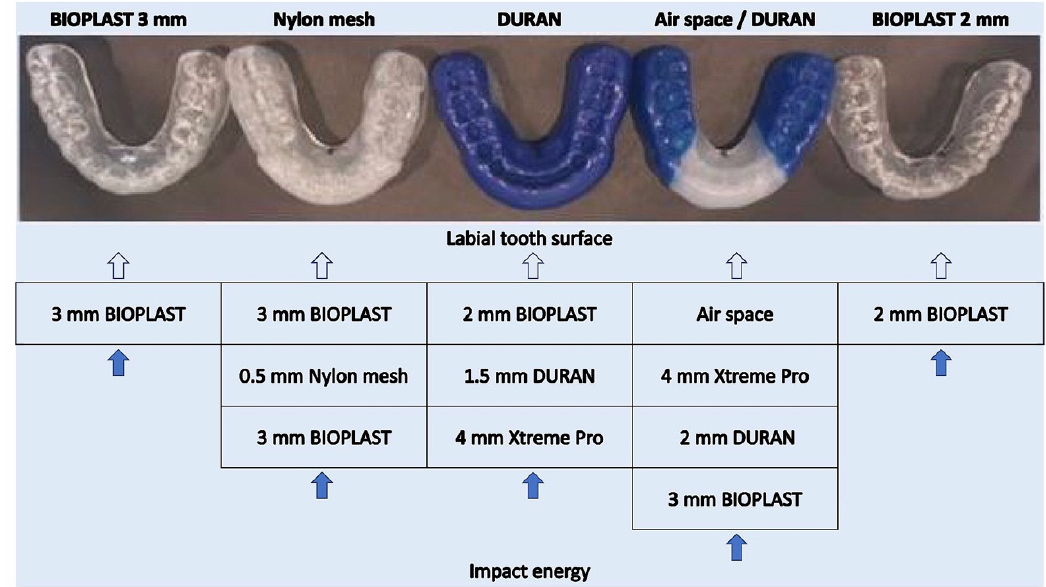
Figure 2. Schematic illustration of all five mouthguard designs with the direction of impact energy.